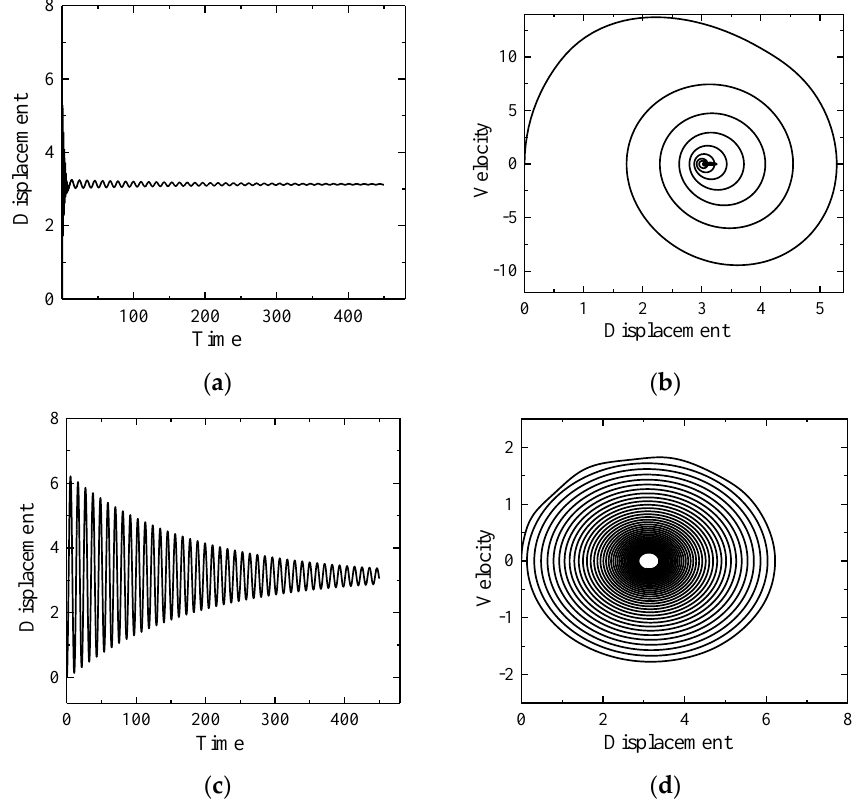
Figure 14. Evolutions of the displacement and speed-displacement diagram of brake disc and brake shoe at the initial braking speed of 10 m / s. ( a ) Evolution of the displacement of the brake shoe. ( b ) Evolution of the speed-displacement diagram of the brake shoe. ( c ) Evolution of the displacement of the brake disc. ( d ) Evolution of the speed-displacement diagram of the brake disc.